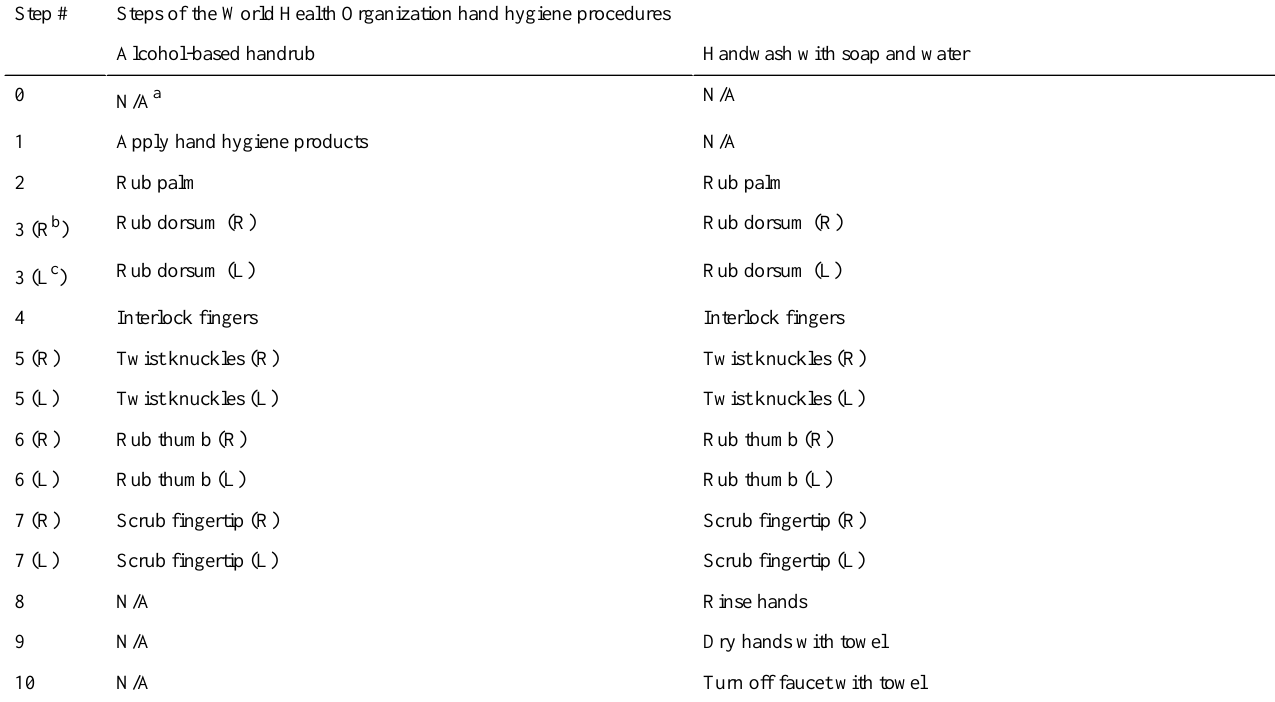
Handwash with soap and waterAlcohol-based handrub